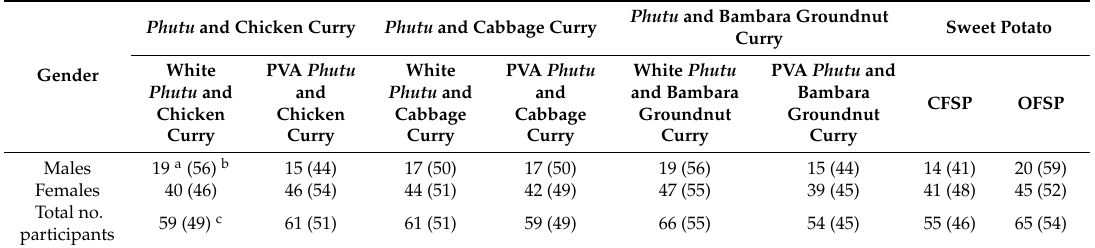
Table 10. Variation in paired preference with gender ( n =